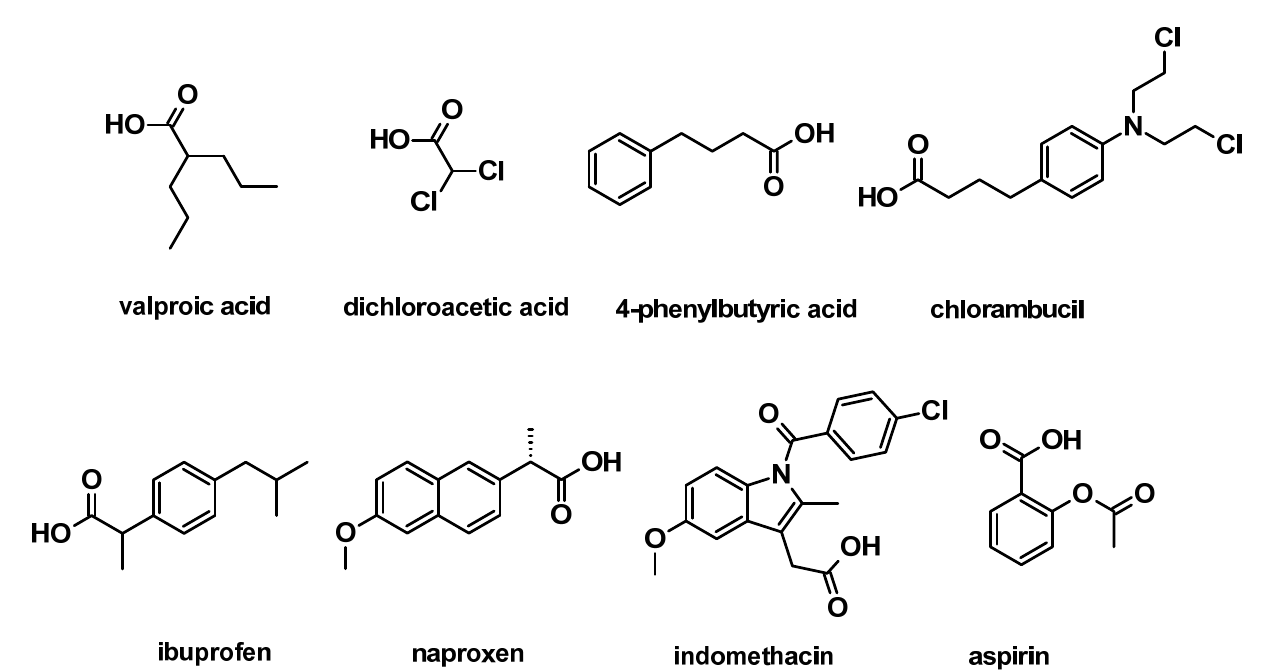
Figure 4. Structures of previously studied bioactive molecules as axial ligands to platinum(IV).